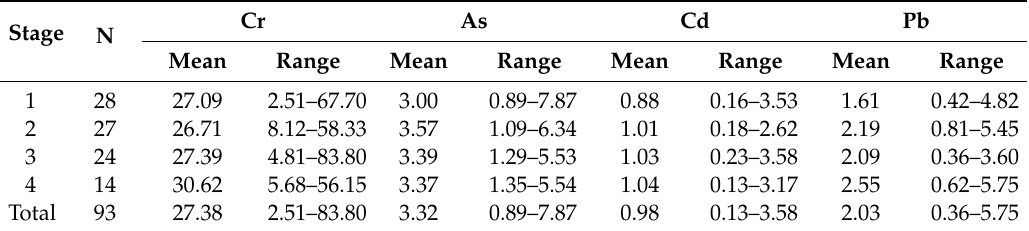
Table 4. Heavy toxic elements ( µ g / kg) in infant formulas of di ff erent stages.